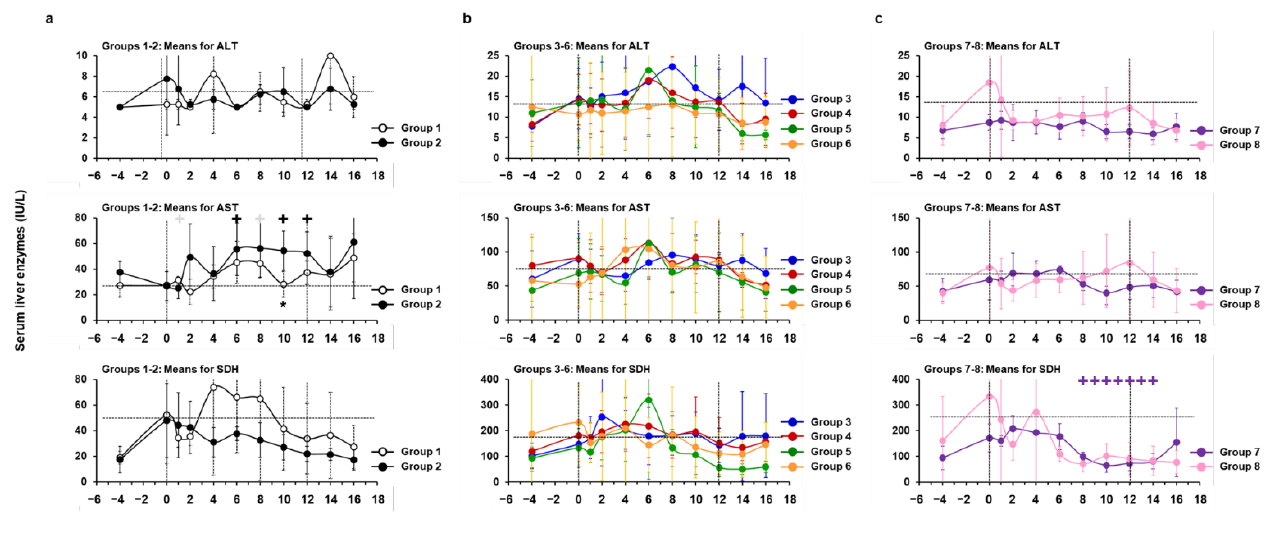
Figure 14. Treatment with hzVSF at the high dose or at an intermediate dose in combination with TAF does not significantly elevate serum liver enzymes. Comparison of mean levels of ALT, AST, and SDH of ( a ) Groups 1–2 treated with placebo or hzVSF at a high dose, ( b ) Groups 3–6 treated with placebo or hzVSF at a low, intermediate, and high dose, and ( c ) Groups 7–8 treated with TAF, alone or in combination with hzVSF at an intermediate dose, relative to the pretreatment baseline (T0). Vertical lines indicate the standard error of the mean. Horizontal dotted lines present the mean levels of Groups 1–2, Groups 3–6, or Groups 7–8 at baseline. The mean AST levels in Group 1 and Group 2 were significantly increased compared to the baseline at weeks 1 and 8 or at weeks 6, 10, and 12, respectively (+: p < 0.05). Compared to Group 1, the mean AST level was significantly increased in Group 2 at week 10 (*: p < 0.05). The mean SDH level in Group 7 was significantly reduced compared to the baseline during weeks 8–14 (+: p < 0.05). Compared to Group 4, the mean SDH level was significantly reduced in Group 5 at week 16 ( p < 0.05). Abbreviation: IU, international unit.